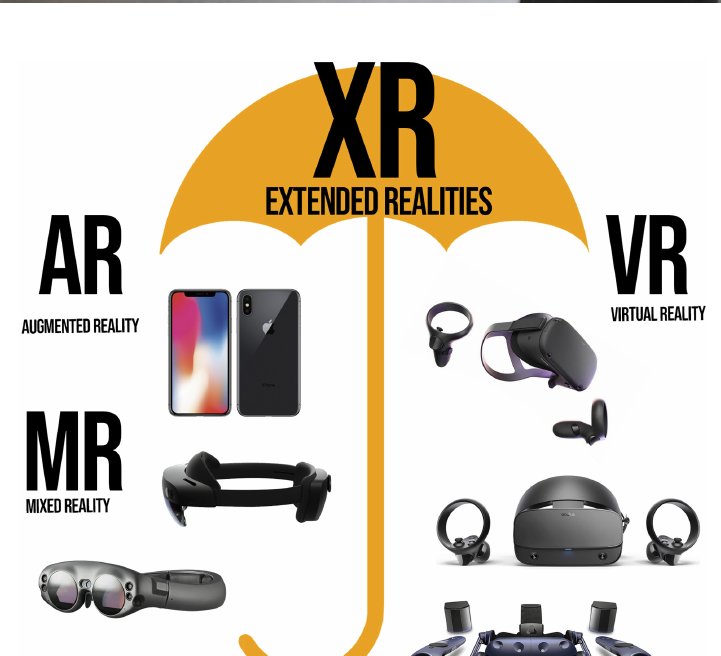
Figure 3. VR view in an immersive VR creation tool such as gravity